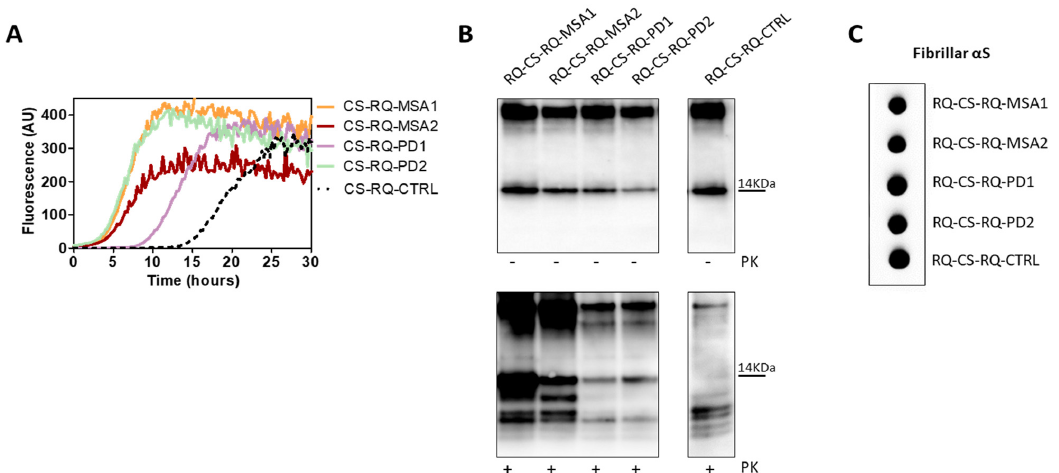
Figure 9. ( A ) α Syn_RT-QuIC analysis of CS-RQ-MSA and CS-RQ-PD. All samples were tested by α Syn_RT-QuIC and induced an efficient seeding activity with respect to the control (CS-RQ-CTRL). Curves represented in the graph were obtained by plotting the average fluorescence intensities of each sample against time. ( B ) Western blot analysis of untreated or PK digested α Syn_RT-QuIC products, collected at 30 h. Undigested samples showed the same biochemical profiles. Western blot analysis of PK digested RQ-CS-RQ-MSA1 and RQ-CS-RQ-MSA2 showed higher resistance to proteolytic digestion than RQ-CS-RQ-PD1 and RQ-CS-RQ-PD2. Membranes were immunoblotted with the AS08 358 antibody. Number on the right indicates the molecular weight. ( C ) Dot blot analysis of α Syn_RT-QuIC products, collected at 30 h. Dot blot analysis performed using the MJFR antibody showed the presence of a strong signal in all samples.